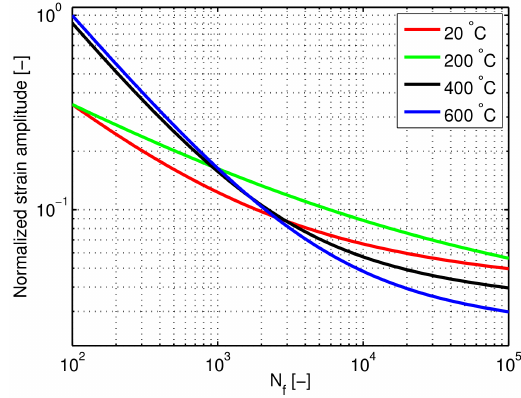
Figure 3. The temperature dependent Manson-Coffin and Basquin